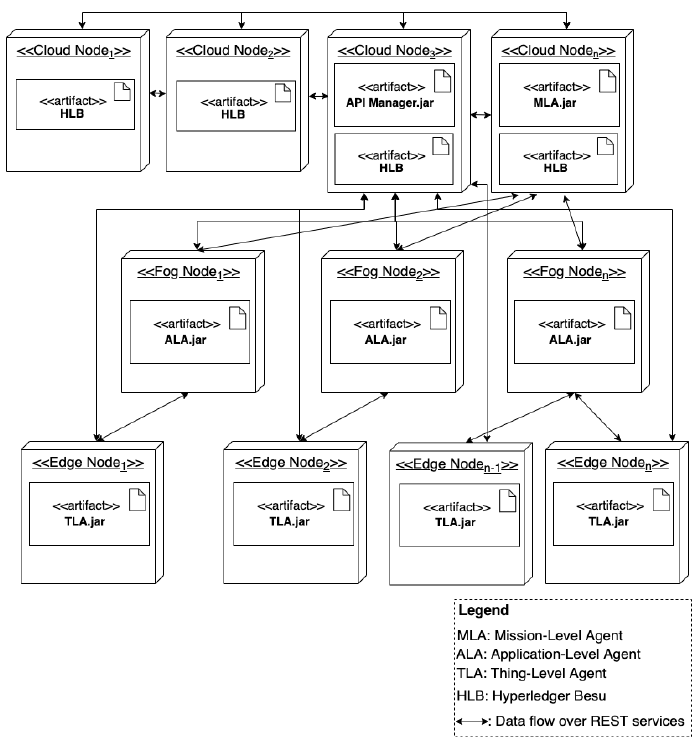
Figure 6. The deployment view of our